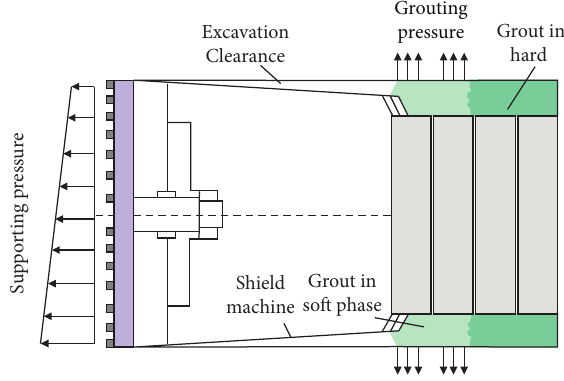
Figure 10: Simulated excavation gap is not filled. Table 2: Physical and mechanical properties of the soil.